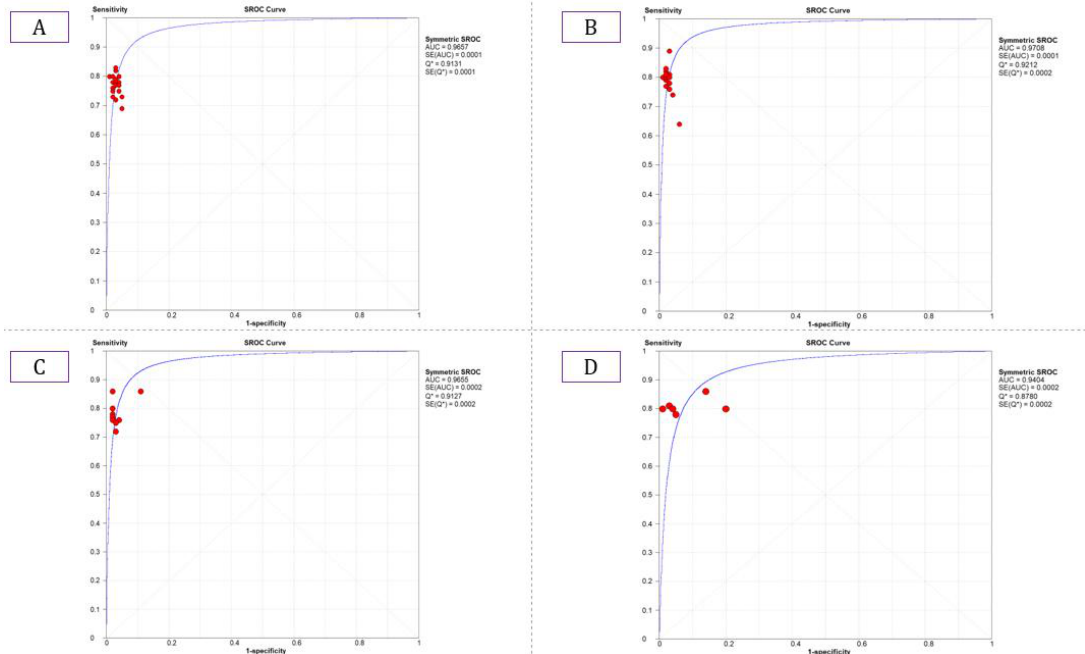
Figure 8. Summarized ROC curve of deep learning (DL) algorithms ( A ) DRIVE, ( B ) STARE, ( C ) CHASE_DB1, and ( D ) HRF.